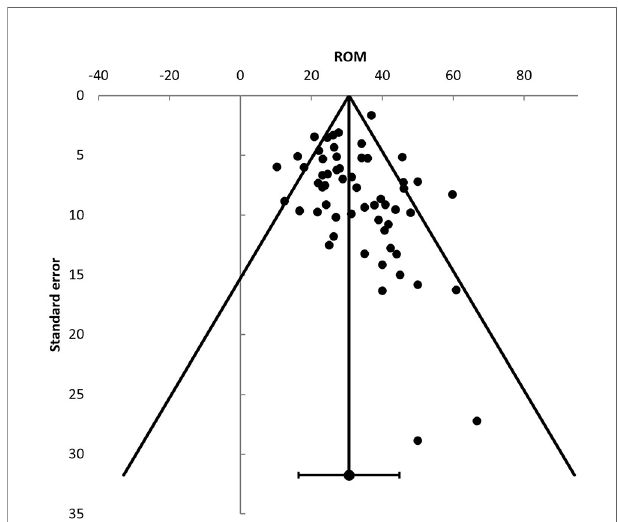
FIGURE 2 | Funnel plot displaying individual studies risk of malignancy (ROM). ROM, risk of